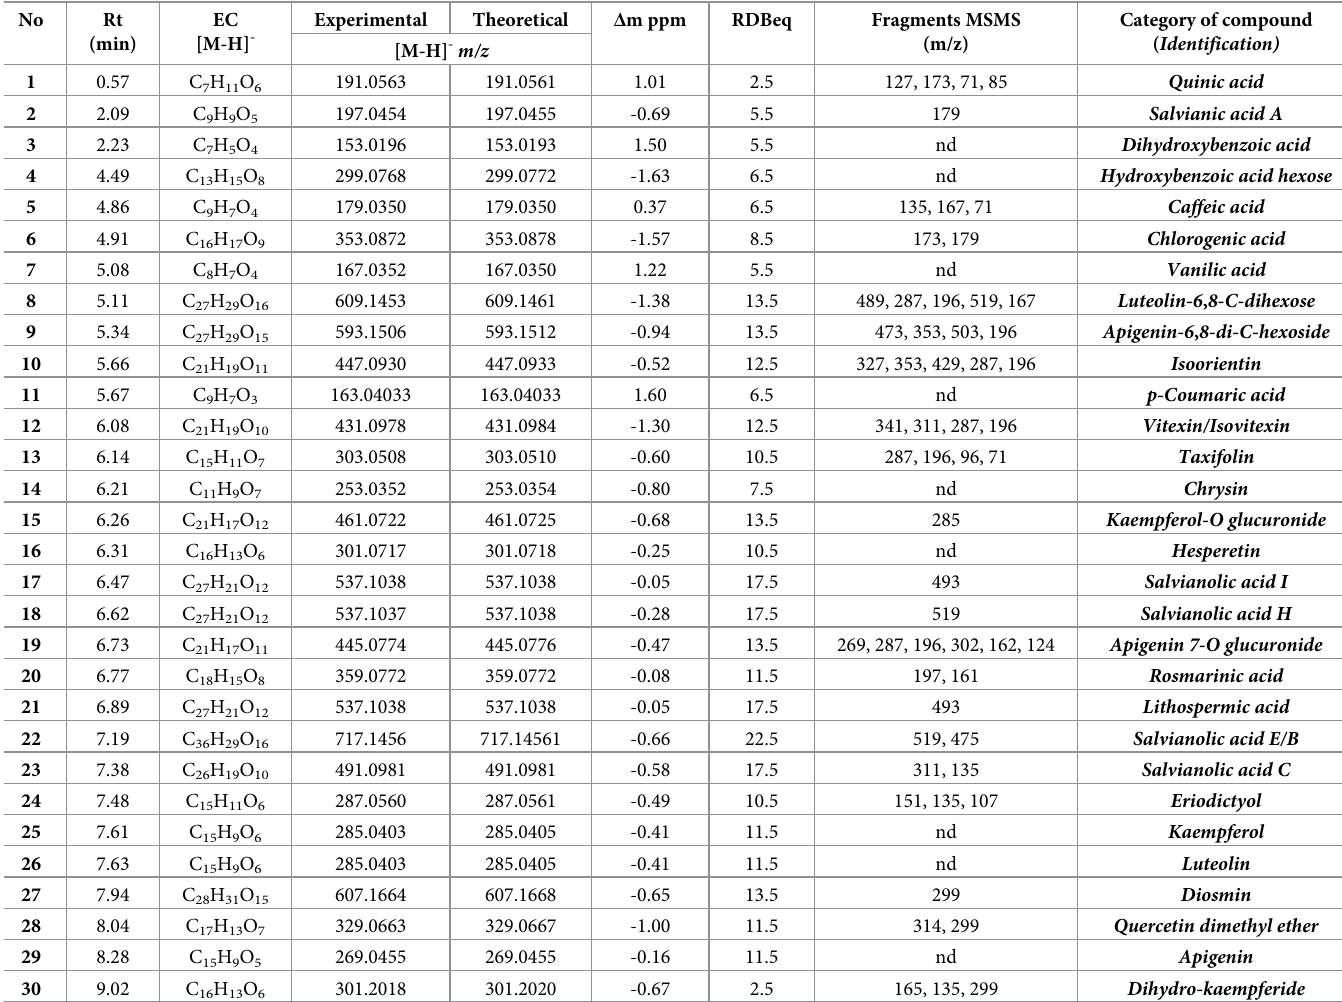
Table 3. LC(ESI-)HRMS of O . vulgare methanol